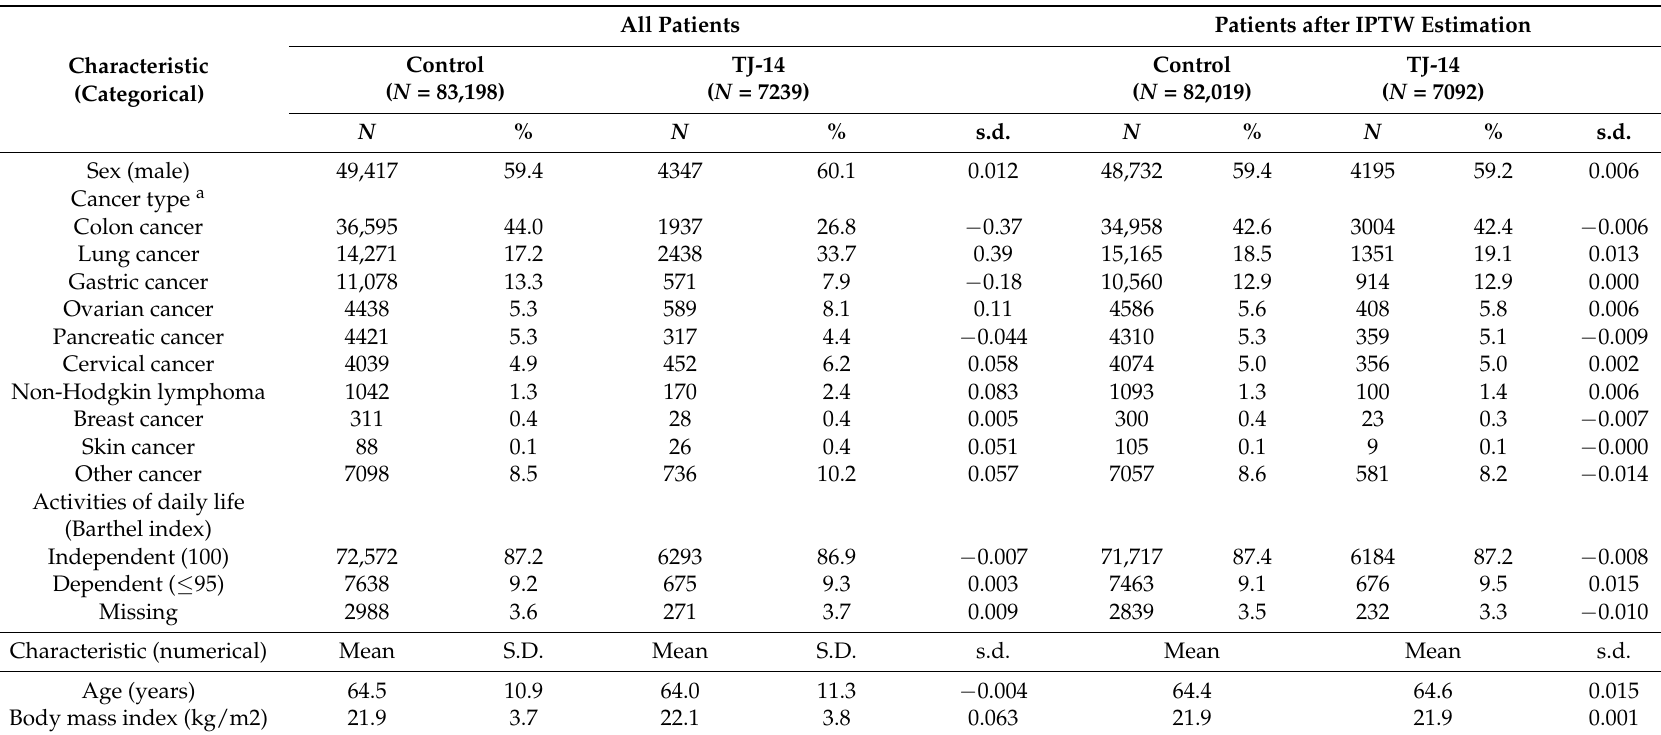
Table 1. Baseline characteristics of patients on first admission for CPT-11 chemotherapy with or without TJ-14, before and after stabilized inverse probability treatment weighting using propensity